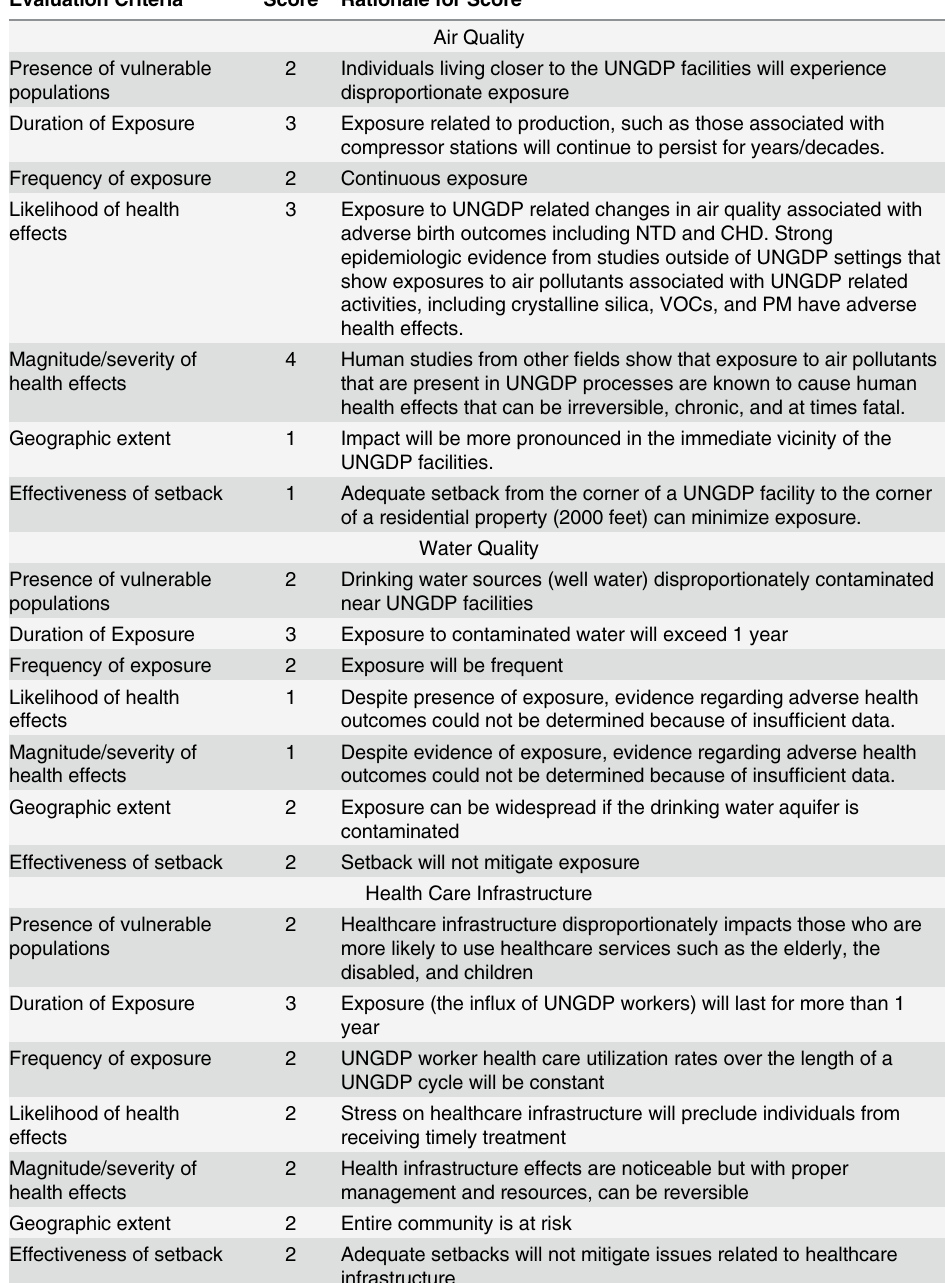
Table 3. Summary of Rationale for Hazard Ranking for Air, Water and Health Care Infrastructure